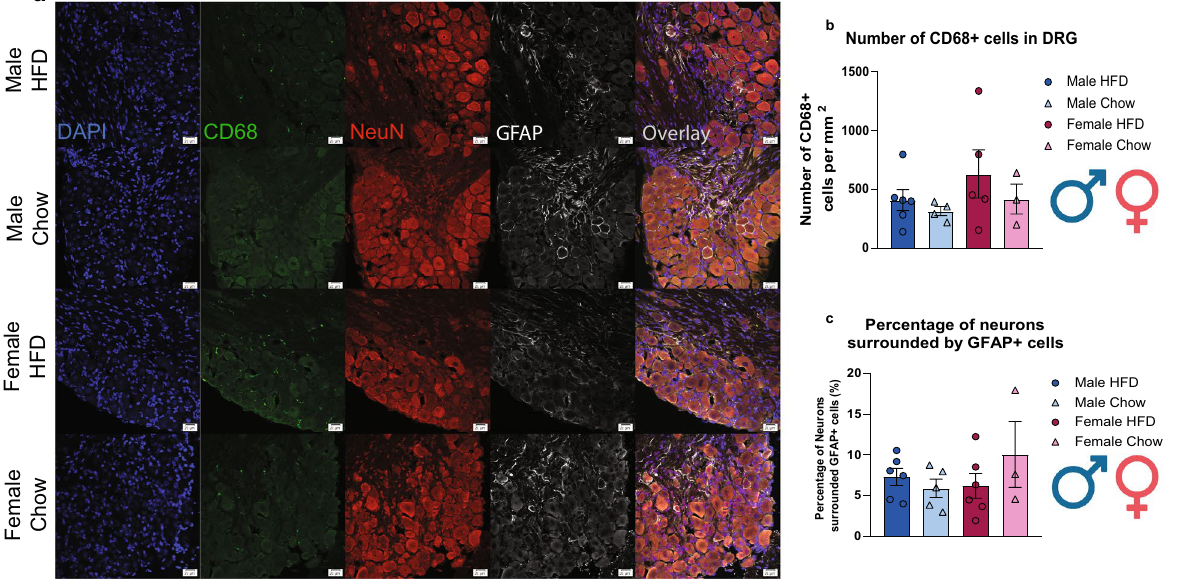
Figure 5. Diet sensitization does not alter monocyte infiltration nor satellite glial cell activation in the lumbar DRGs. ( a ) Ipsilateral lumbar (L3-L5) DRGs from both diet groups were immunostained with DAPI (blue), CD68 (green), NeuN (red), and GFAP (white). ( b ) There were no changes in monocyte infiltration nor ( c ) were there an increase in GFAP expression in satellite glial cells between HFD males (n = 6) and females (n = 5) and chow males (n = 4) and females (n = 3). Scale bar: 20